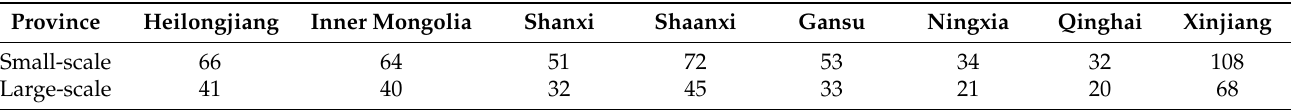
Table 1. Provincial distribution of small-scale and large-scale farmers (unit: households).